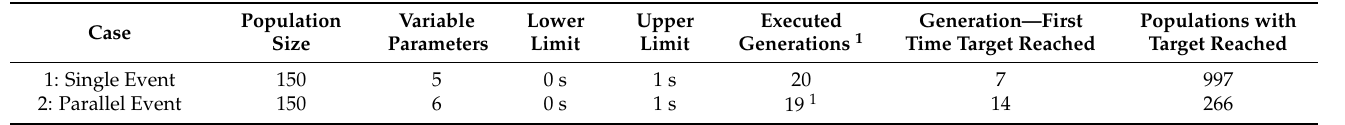
Table 2. Overview of parameter settings of the genetic algorithm and the results.